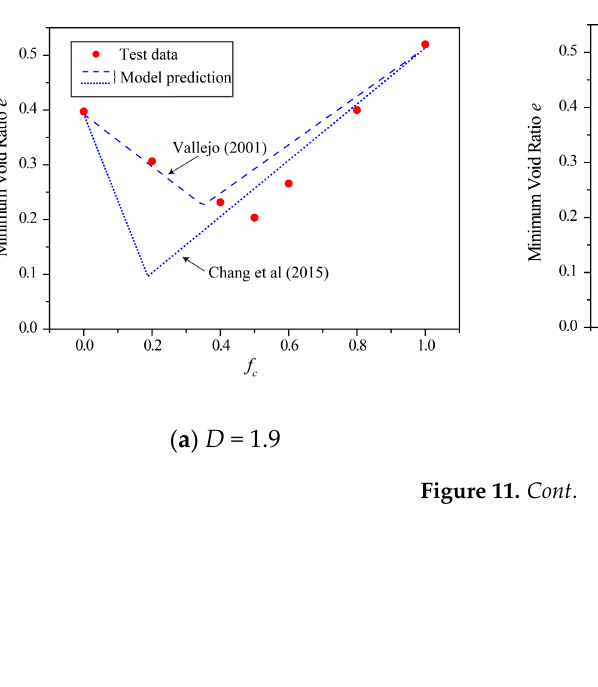
of gap-graded SRMs.